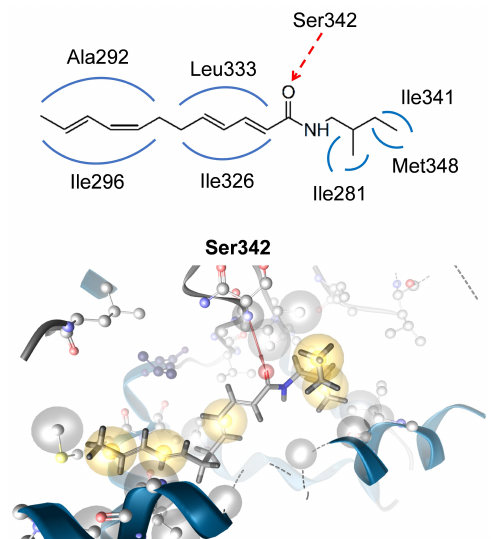
Figure 9. The predicted binding modes of dodeca-2 E ,4 E ,8 Z ,10 E -tetraenoic acid 2-methylbutylamide to the PPAR γ LBD illustrated in a 2D-model ( top ) and 3D-model ( bottom ). The chemical interaction pattern is the same for dodeca-2 E ,4 E ,8 Z ,10 Z -tetraenoic acid 2-methylbutylamide. Binding modes to the LBD in the 2D-model are color-coded: red dashed arrow = hydrogen bond; blue line = hydrophobic interactions.